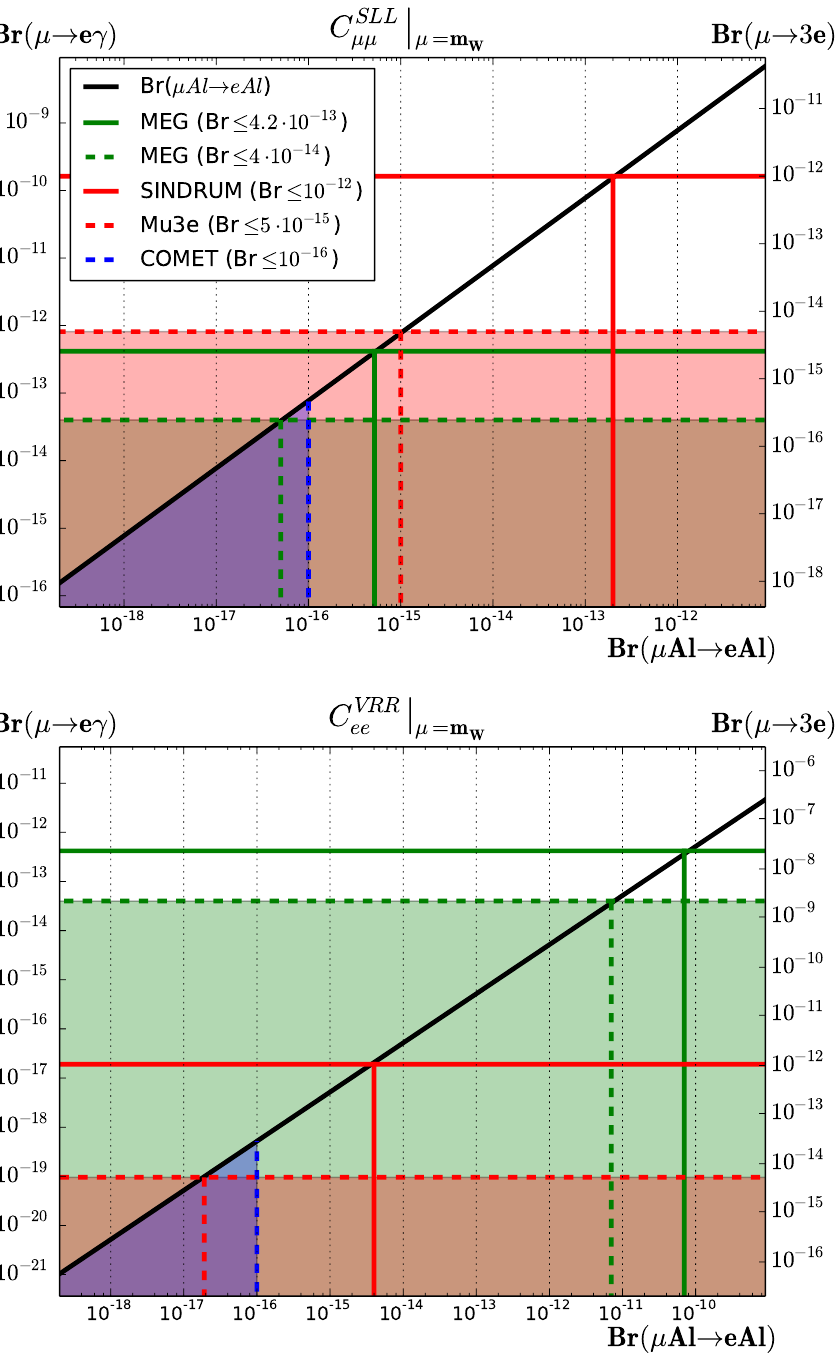
Figure 2. Br( (cid:22) ! e(cid:13) ) (Br( (cid:22) ! 3 e )) plotted on the left (right) y -axis against Br( (cid:22)N ! eN ) for a (cid:12)xed value of C S LL (upper panel) and C V RR (lower panel) given at the scale (cid:22) = m W . Current (cid:22)(cid:22) ee and future experimental limits are displayed.